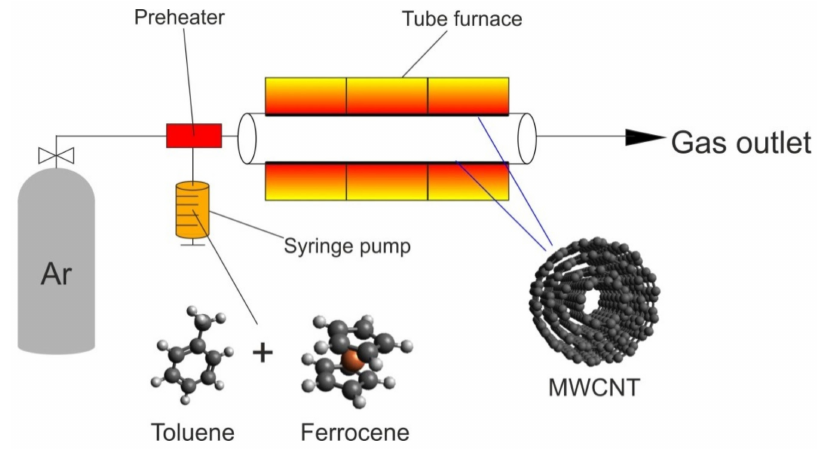
Figure 1. Scheme of multi-walled carbon nanotube (MWCNT)